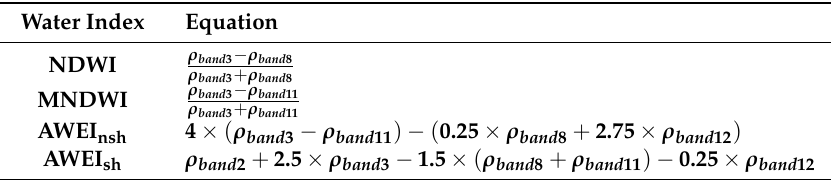
Table 2. Calculations of water indexes using Sentinel-2